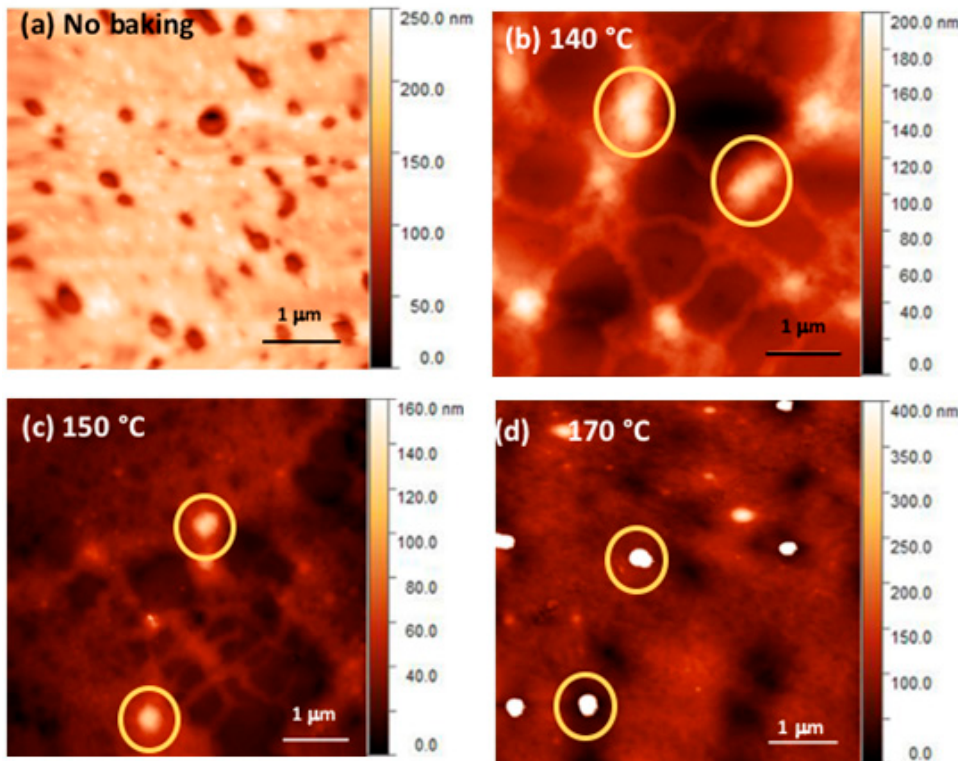
Figure 4. AFM images of blends of Ppy9 and CdDMASe before annealing ( a ) and after annealing at 140 °C for 15 min ( b ) 150 °C for 15 min ( c ) and 170 °C for 15 min ( d ). Large aggregates disappear at higher baking temperatures. The yellow circles highlight the clusters as described in the text. The cross sections of the films are reported in the Supplementary Information.